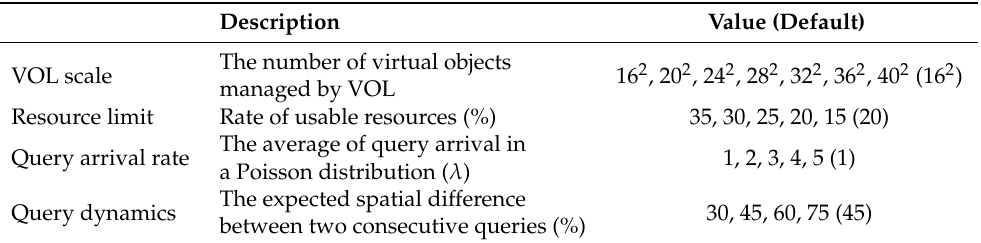
Table 3. Virtual object layer (VOL) parameter